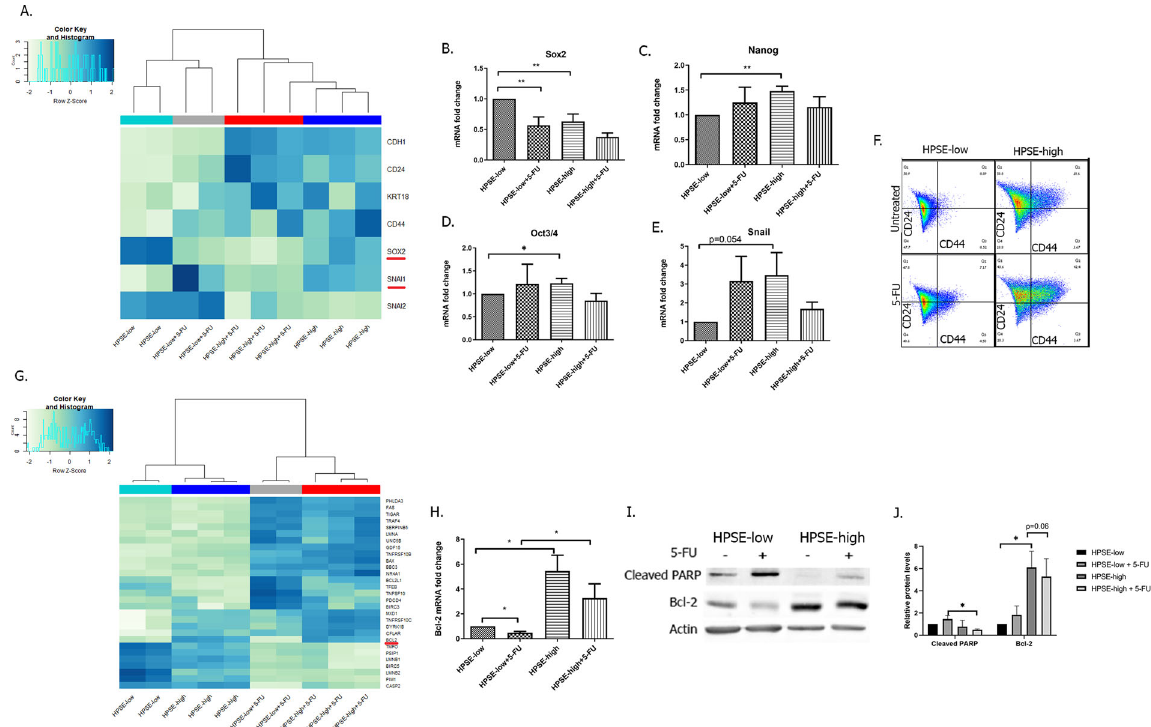
Fig. 4 Heparanase promotes tumor progression and increases cell survival via EMT, stemness, and an anti-apoptosis pathway. A heat map and hierarchical clustering of stemness and EMT genes. B – E Expression of B Sox2, C Nanog, D Oct3/4 and E Snail in HPSE-low or HPSE- high cells following 5-FU treatment for 24 h, as determined by real-time PCR. F FACS analysis of the cell surface markers CD24 and CD44 in HPSE-low or HPSE-high following 5-FU treatment for 72 h. The provided results are from a representative experiment repeated three times. G heat map and hierarchical clustering of core apoptosis-related genes. H Expression of Bcl-2 in HPSE-low or HPSE-high cells following 5-FU treatment for 24 h, as determined by real-time PCR. I Western blot analysis and J quanti fi cation of total protein levels of Bcl-2 and cleaved PARP from HPSE-low or HPSE-high following 5-FU treatment for 24 h. All blots derive from the same experiment and were processed in parallel. For all experiments: * p < 0.05, ** p <